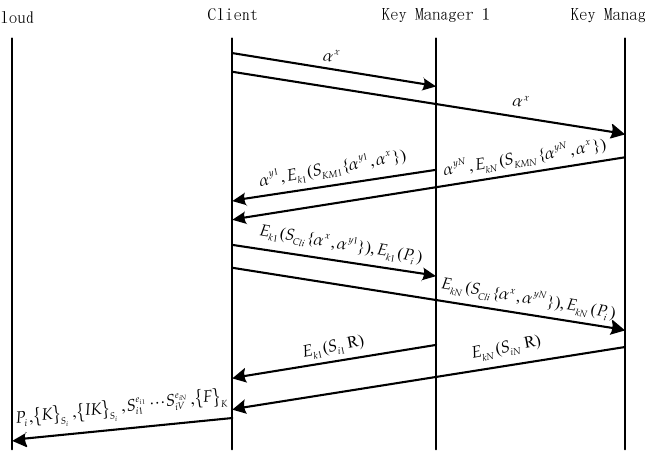
Figure 2. Single key manager DaSCE file upload. The multi-key managers file upload, according to the Shamir ( k , N ) threshold secret sharing algorithms, can be seen in Figure 3. S i is divided into N shares, and each N KM i generates a pair of public and private keys.